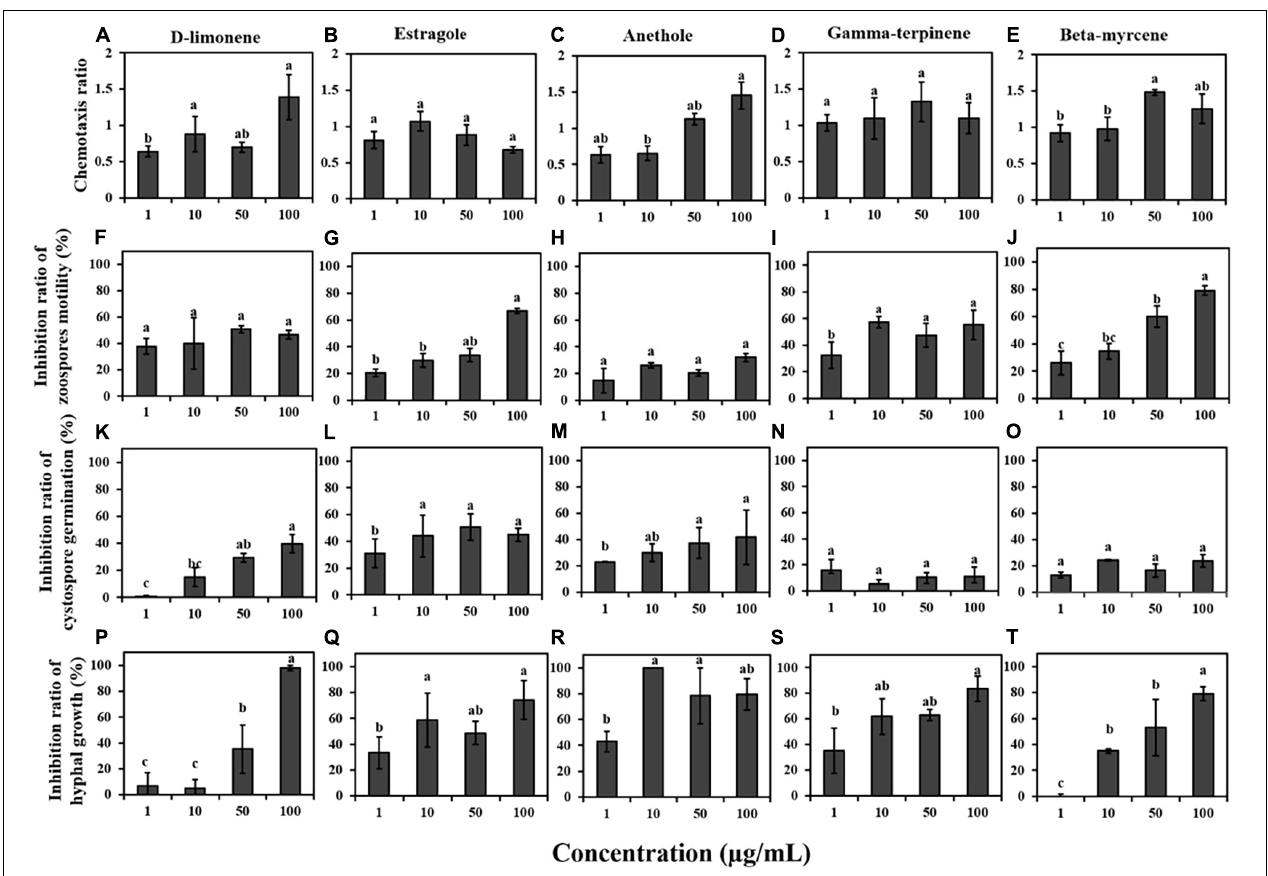
FIGURE 5 | (A–E) Chemotaxis of terpene compounds on zoospores. (F–J) Inhibition of terpene compounds on zoospore motility of P . capsici . (K–O) Inhibition of terpene compounds on cystospore germination. (P–T) Inhibition of terpene compounds on hyphal growth. Significant differences are based on one-way ANOVA ( p < 0.05). The error bars indicate the standard errors of the means ( n = 3).